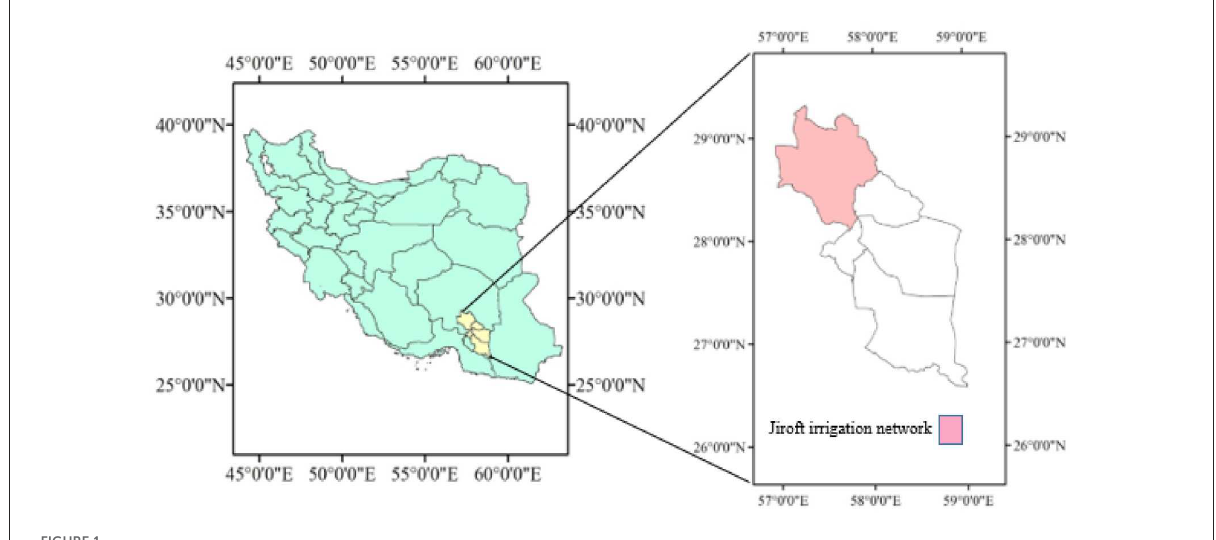
FIGURE1 Location of irrigation network of Jiroft